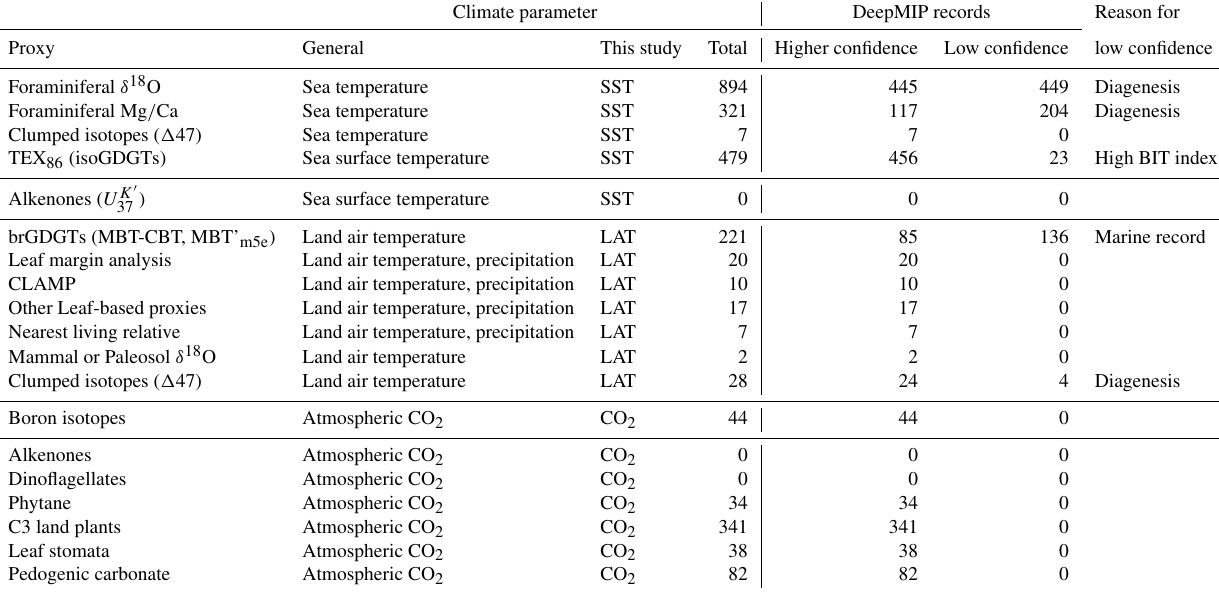
Table 1. Number of sea surface temperature (SST), land air temperature (LAT) and atmospheric CO 2 estimates in the DeepMIP database (v.0.1), including the number of samples in each time slice which meet criteria for use as temperature estimates (moderate to high confidence) and low-confidence temperature estimates, which are either included data summaries with caution (diagenesis, calibration uncertainty) or excluded (high BIT